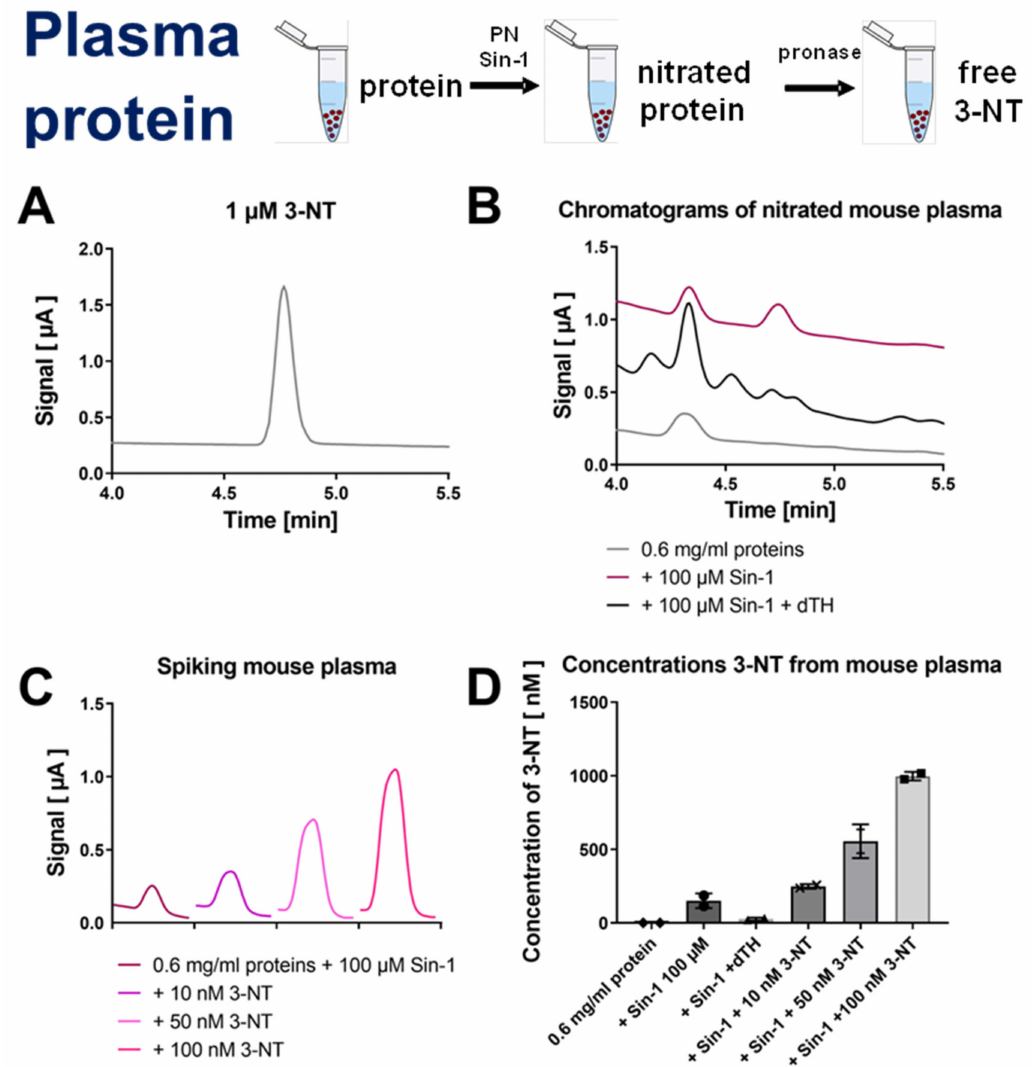
Figure 4. Detection of free 3-NT from nitrated plasma proteins by HPLC / ECD. Plasma was nitrated by Sin-1 and generated 3-NT was reduced by dTH. These samples were subjected to pronase digest before HPLC / ECD analysis. ( A ) Representative chromatogram of authentic 3-NT standard. ( B ) Representative chromatograms of Sin-1 treated plasma proteins after digest with or without dTH. ( C ) Spiking of potential 3-NT peak with low concentrations of authentic 3-NT standard to proof the identity of this peak. ( D ) Quantification of 3-NT yield of experiments shown in panels ( B , C ). HPLC / ECD analysis was performed with 20 µ L of sample at 27 ◦ C with isocratic elution (1.3 mL / min, mobile phase: 26.3 mM sodium citrate and 10.9 mM sodium at pH 4.75 with 3 v / v % methanol; 3-NT eluted at 4.76